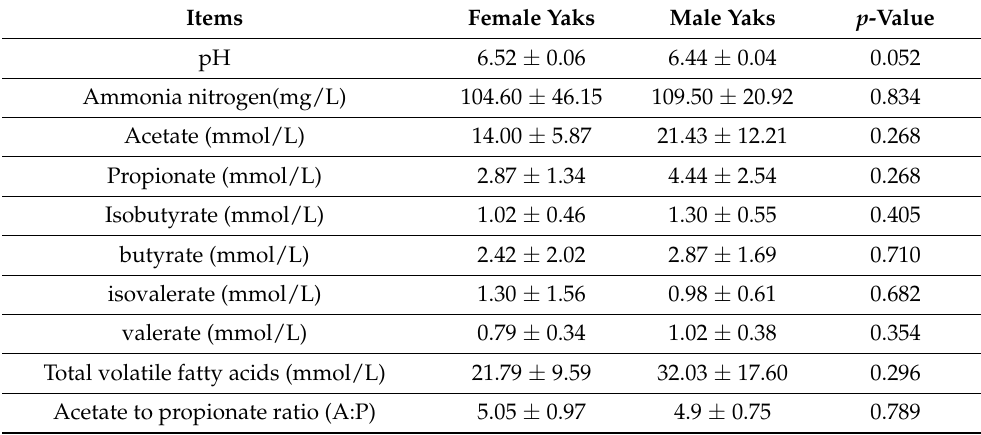
Table 1. Rumen fermentation parameters of male and female